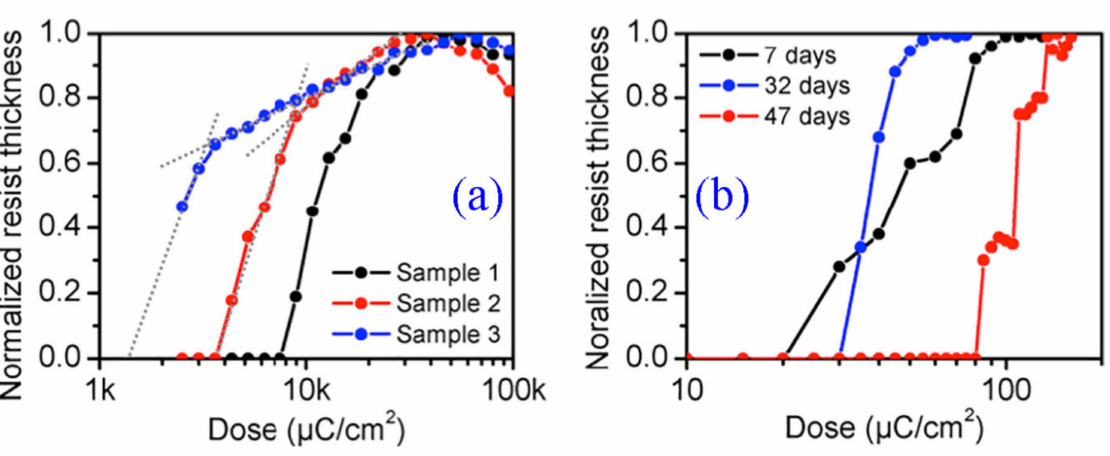
Figure 16. ( a ) EBL contrast curve of different samples at different development time. ( b ) FHIB contrast curve. Reprinted with permission from [153], Copyright 2018,